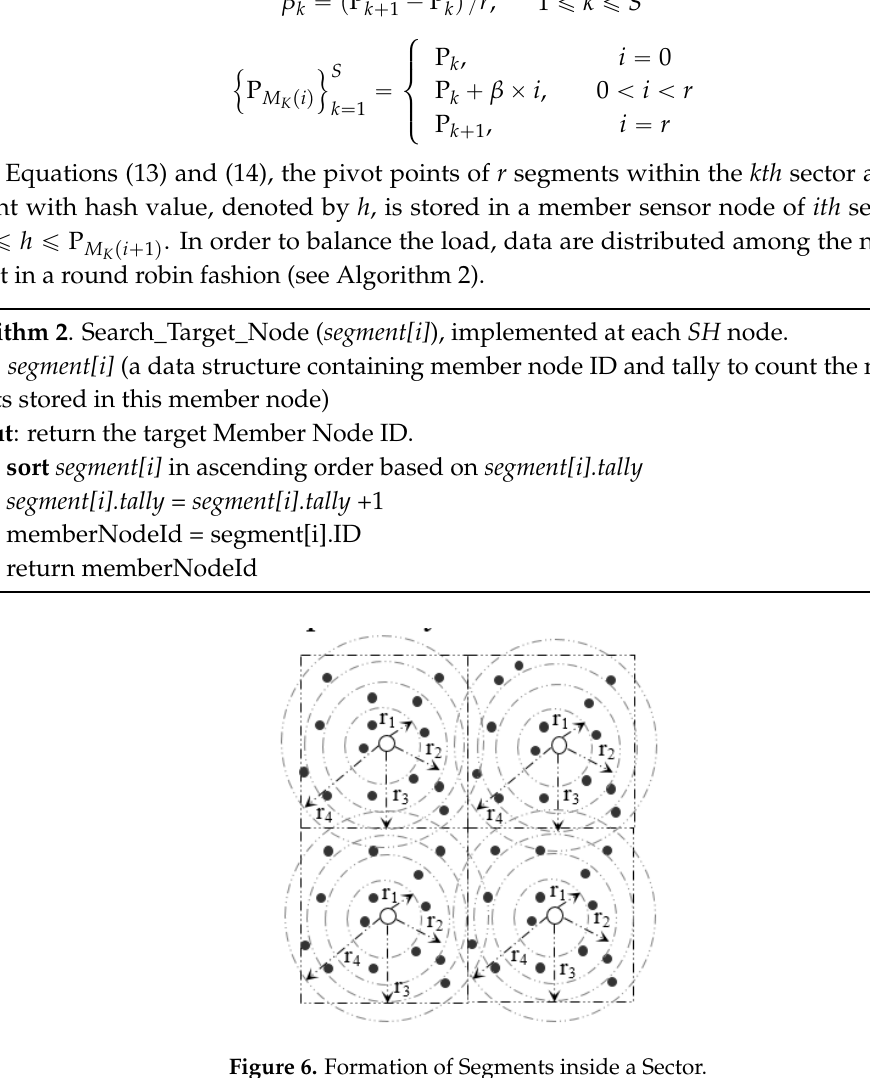
Figure 7. Segmentation architecture of member nodes inside a sector.